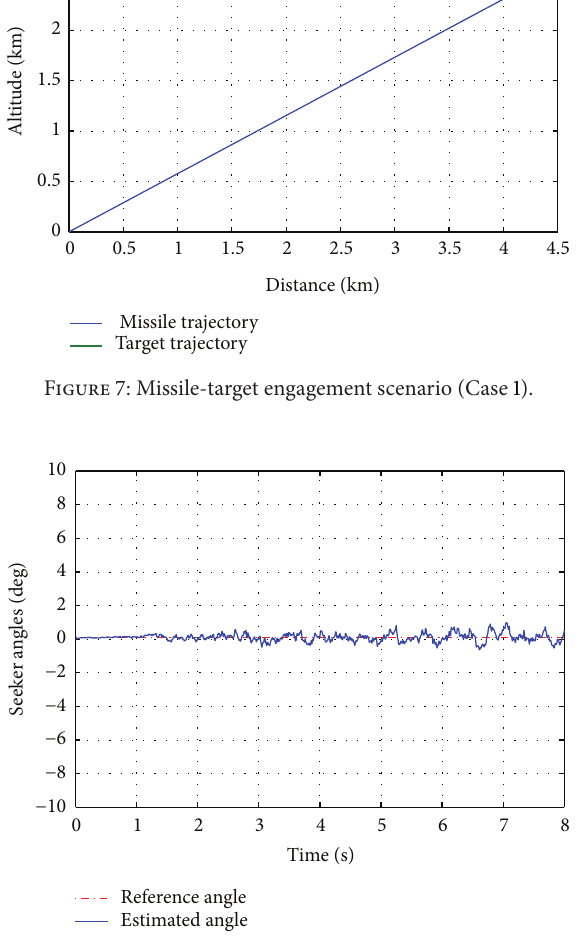
Figure 8: Angle trajectories for gimbaled system (Case